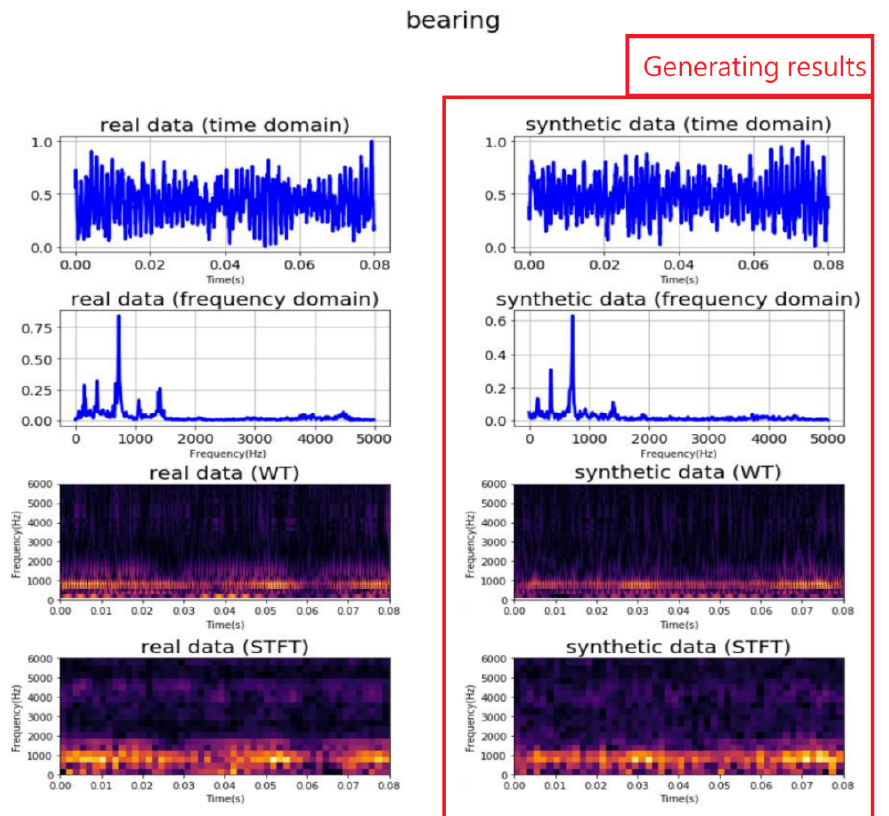
Figure 10. Comparison of actual and generated data of bearing outer ring damage.